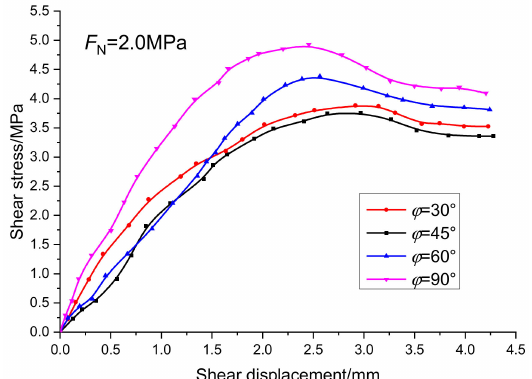
Figure 14. Relationship curves between normal stress and normal displacement under di ff erent joint dip angles.